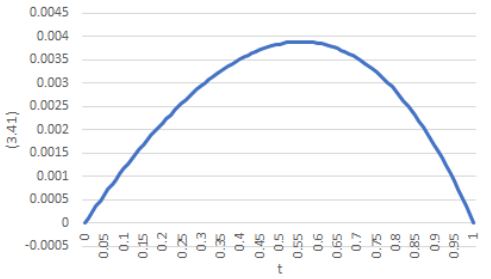
Figure 3. Error in the approximation of